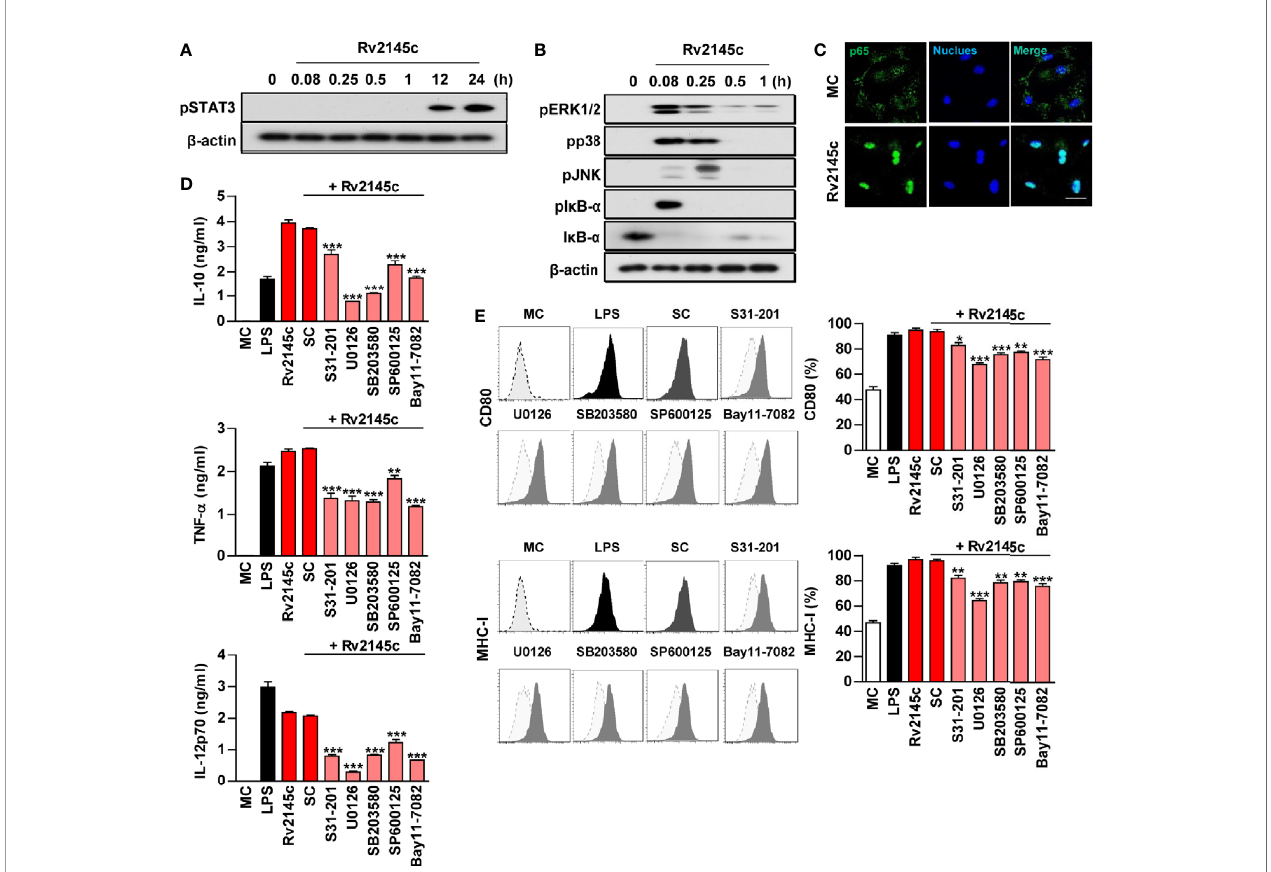
FIGURE 3 | Rv2145c induces macrophage activation via STAT3, MAPK, and NF- k B. BMDMs stimulated with Rv2145c for the indicated times were lysed, and the proteins in the total cell lysate were separated by SDS-PAGE followed by immunoblot analysis using antibodies against (A) phospho-STAT3 and (B) phospho-ERK1/ 2, phospho-p38, phospho-JNK, phospho-I k B- a , I k B- a , and b -actin. This image is representative of three experiments showing similar results. (C) BMDMs were plated in covered glass chamber slides and treated with Rv2145c for 1 h, and the immunoreactivity of the p65 subunit of NF- k B in cells was determined by immuno fl uorescence. Scale bar, 10 m m. (D, E) BMDMs were pretreated with pharmacological inhibitors of STAT3 (S31-201, 5 m M), ERK (U0126, 10 m M), p38 (SB203580, 20 m M), JNK (SP600125, 10 m M), NF- k B (BAY11-7082, 5 m M), or DMSO (SC; solvent control) for 1 h prior to treatment with Rv2145c (10 m g/ml). After 24 h, the amounts of IL-10, TNF- a , and IL-12p70 in the culture medium were measured by ELISA (D) . The mean ± SD is shown for three independent experiments. The expression levels of CD80 and MHC-I were analyzed by fl ow cytometry (E) . Bar graphs show percentages (mean ± SD of three separate experiments) for each surface molecule on F4/80 + cells. * p < 0.05, ** p < 0.01, or *** p < 0.001 for each inhibitor treatment compared with Rv2145c-treated controls. MC, medium controls; SC, solvent